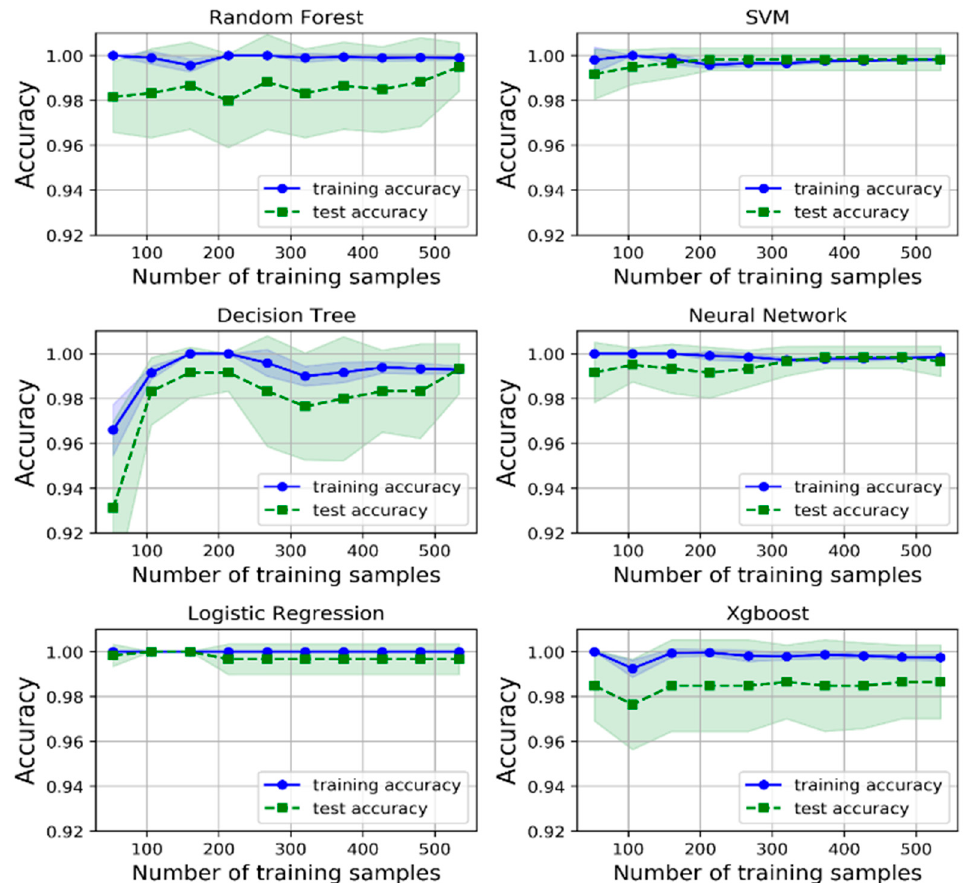
Figure 2. Effects of the sample number on performance of each algorithm.